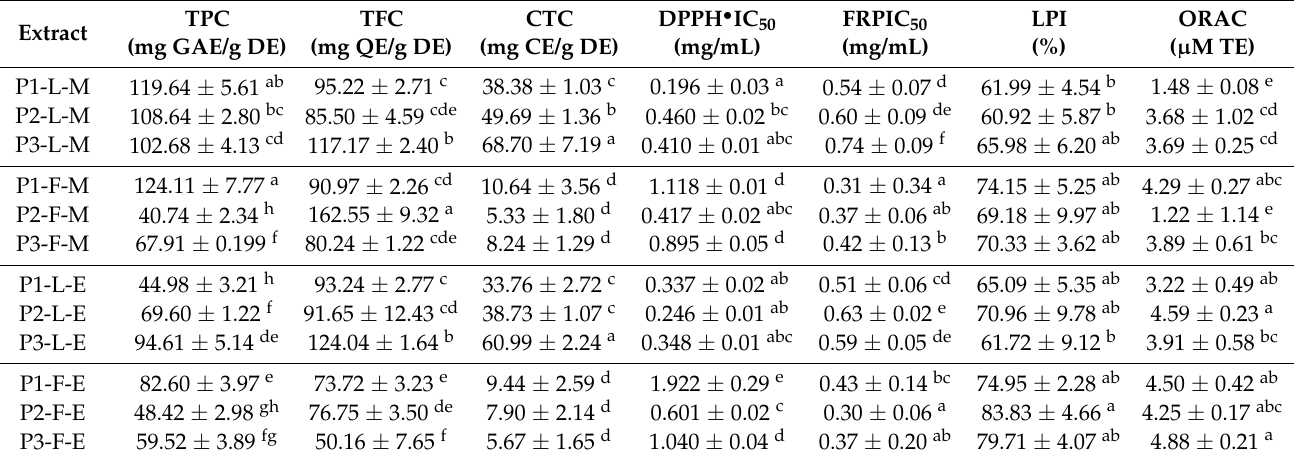
Table 2. Total phenolic, flavonoid, and tannin contents, free radical scavenging activity, ferric reducing antioxidant power, lipid peroxidation inhibition, and oxygen radical absorbance capacity of extracts from leaves and flowers of Cosmos sulphureus